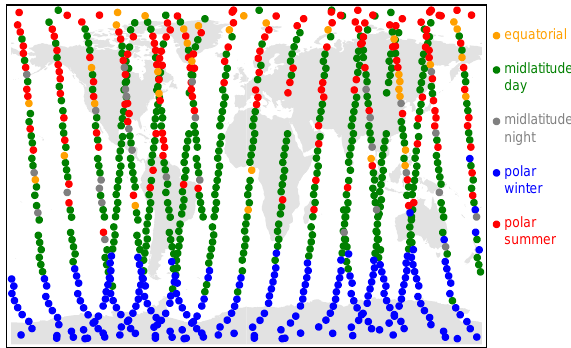
Fig. 15. Linearisation points selected within an ensemble (equa- torial, midlatitude day, midlatitude night, polar summer and polar winter profiles) using Eq. (21) for the retrieval of 7 June 2007.